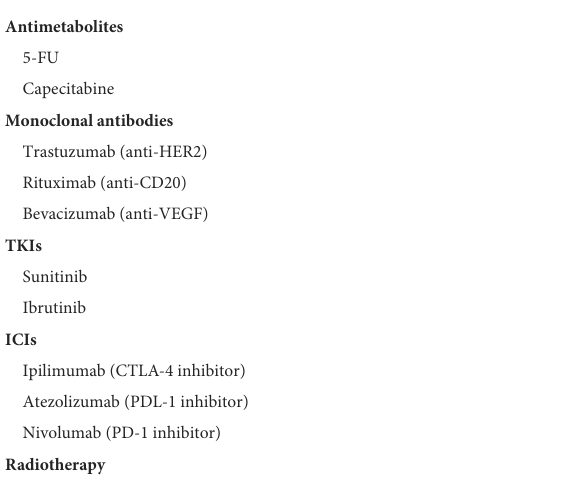
TABLE 4 Main cancer therapies that can induce Takotsubo syndrome in cancer